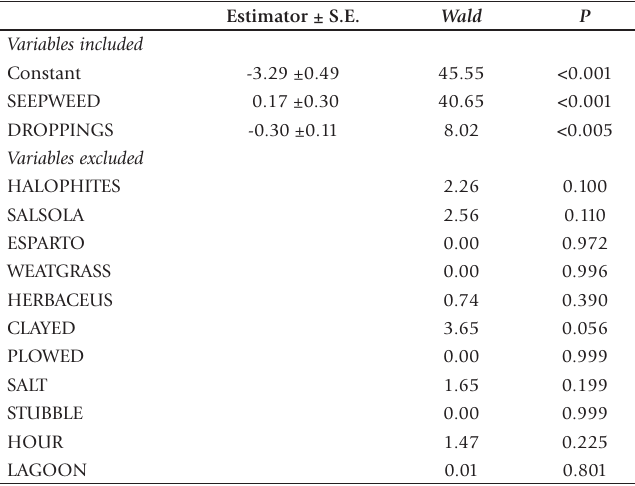
Table 1. Results of the forward stepwise logistic regression analysis for presence of Mioscirtus wagneri (PRESENCE) in relation to the different explanatory variables